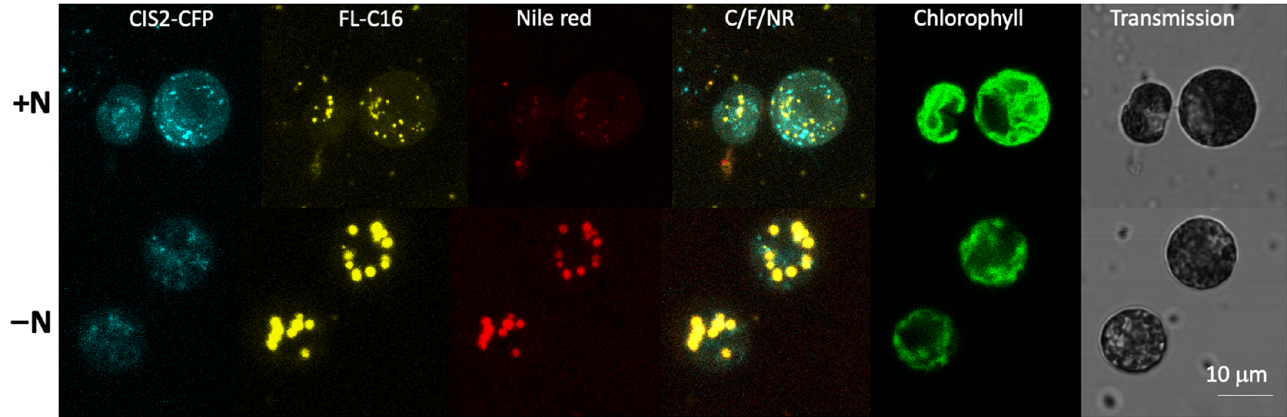
Figure 4. Exogenously added FAs are found in lipid droplets in nitrogen-deficient conditions. C. reinhardtii UVM4 expressing CIS2-CFP was cultured in nitrogen-replete (+N) or -deficient ( − N) conditions. FL-C16 (20 µM) was added to the culture medium 3 d before or 1 h before microscopy for the +N condition or − N condition, respectively. FL-C16 signals (yellow) were not co-localized with peroxisomal CIS2-CFP signals (cyan) in either condition. Nile red signals co-localized with FL-C16 in the − N condition.